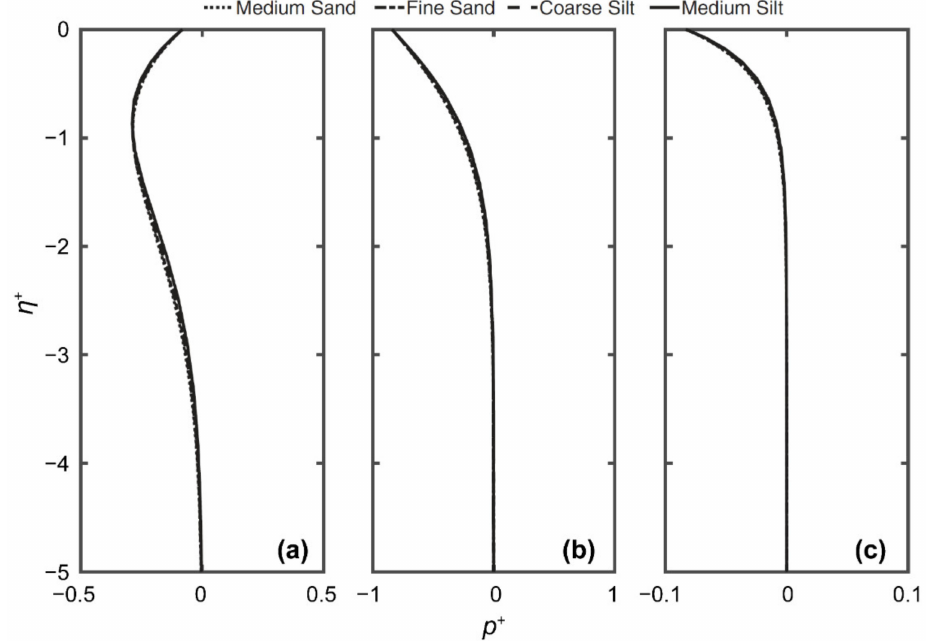
Figure 8. Pore-pressure changes in the vertical direction by ISWs. For different seabed materials, the changes of pore pressure, where ( a ) is after the ISW trough, ( b ) is under the ISW trough, and ( c ) is before the ISW trough. Panels ( a – c ) adapted from Rivera-Rosario et al. [21], with permission from